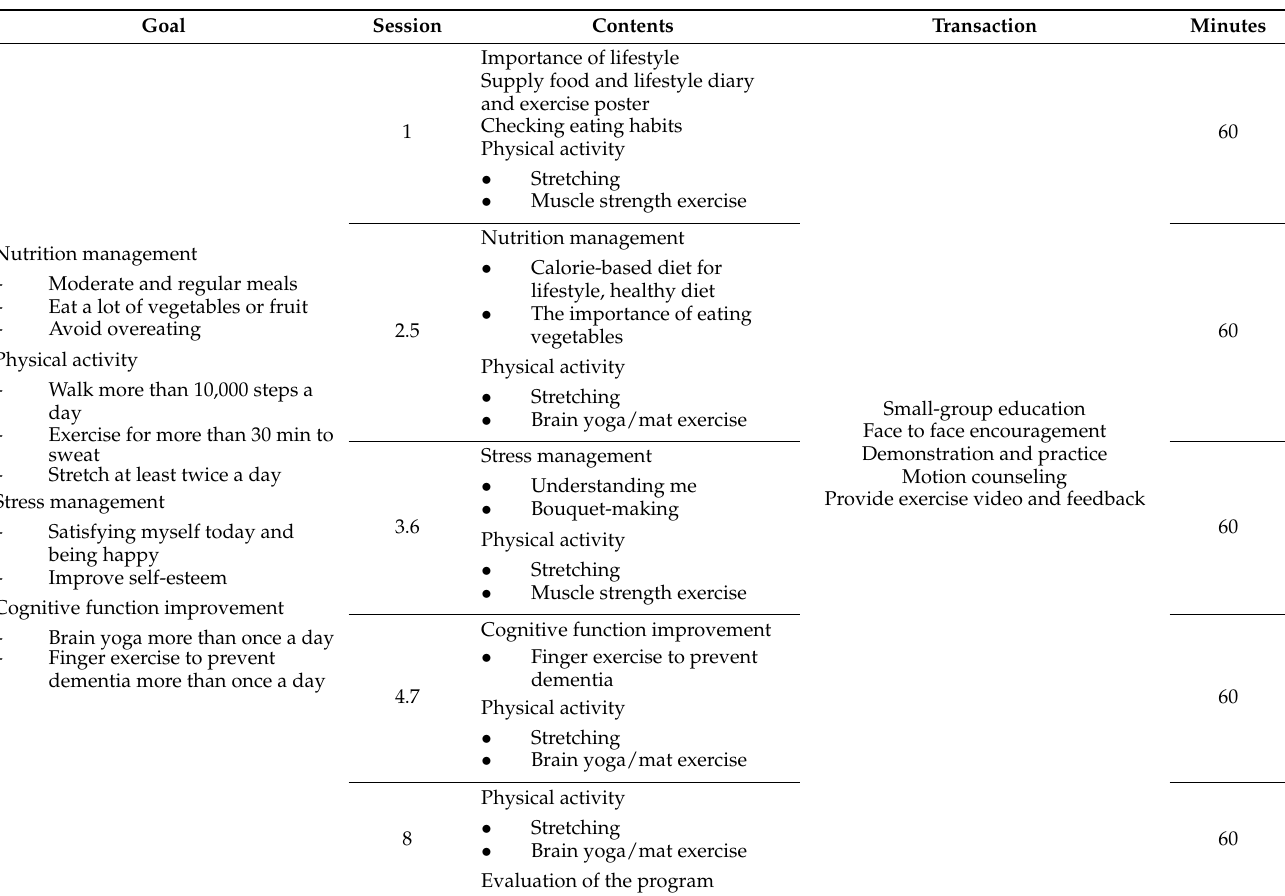
Table 1. Contents of the lifestyle intervention